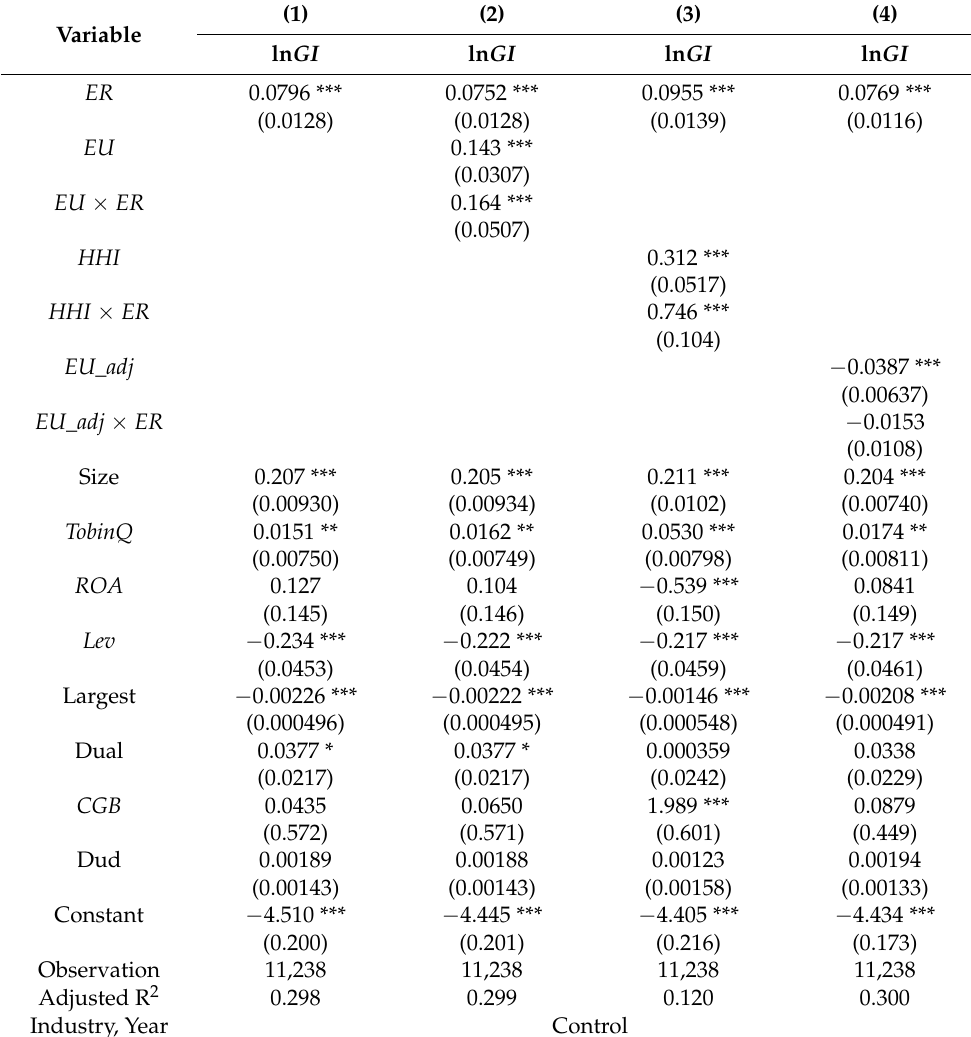
Table 9. Regression Analysis of Environmental Uncertainty, Environmental Regulation and Enter- prises’ Green Technological Innovation of